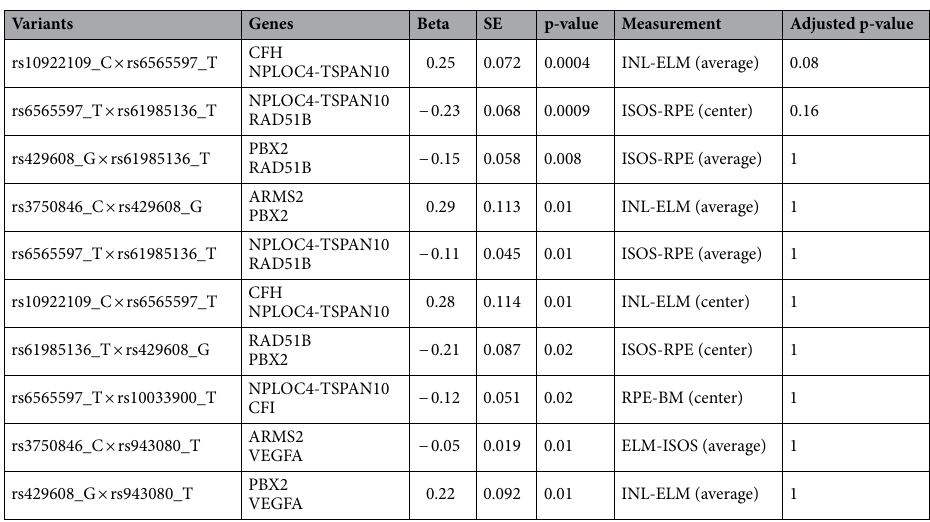
Table 4. Results of linear models testing the effects of 10 most significant AMD SNP interactions on SD-OCT measurements. Models were adjusted for sex, age, spherical equivalent, smoking status. Field “Interactions” displays rs ID numbers and the risk alleles of the variants included in the interactions, that were nominally associated with outer-retinal layers. The column “Measurements” lists SD-OCT measurements that were tested. The columns “Beta”, “SE”, “p-value” and “Adjusted p-value” denote the change of SD-OCT measurements (in microns), standard errors, 95% confidence intervals, p-values and Bonferroni-corrected p-values for each tested interaction. The table includes results for 32,113 participants from UK Biobank